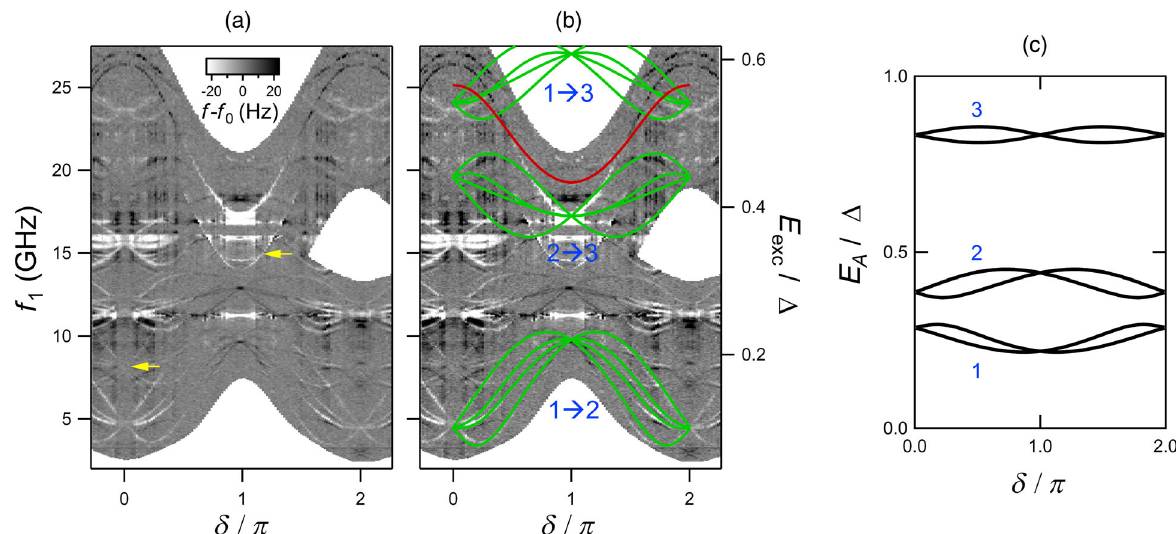
¼ − 0 . 89 V, with yellow arrows pointing to transition lines that are replicas of lines appearing exactly 3.26 GHz FIG. 9. (a) Data at V g above. (b) Same data superimposed with predictions of the single-barrier model using parameters corresponding to the spectrum of ABS shown in (c). Single-particle transitions (green lines) between the three manifolds labeled 1, 2, 3 in (c) are visible in the data. Red line in (b) is the pair transition leading to two quasiparticles in manifold 1.